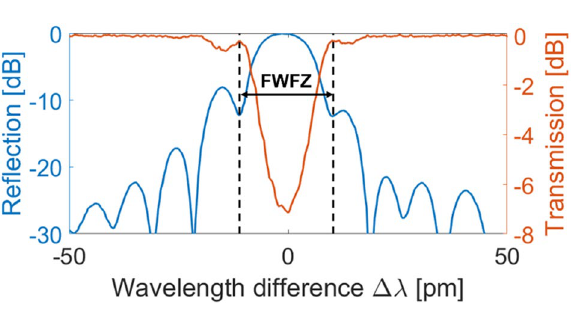
Figure 7. Reflexion (blue) and transmission (orange) spectrum of the FBG, showing the 21.5 pm full width at first zeroes (FWFZ) bandwidth, centered at 1571.86